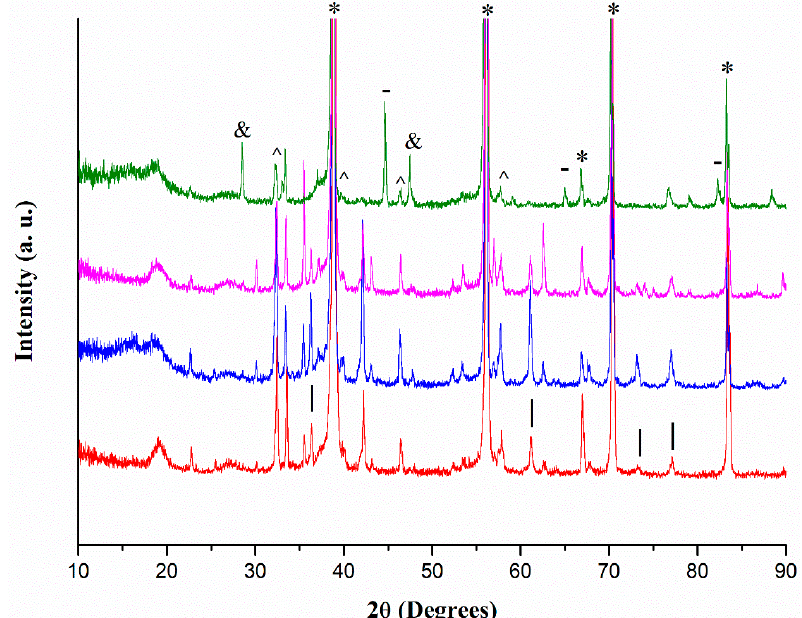
Figure 5. XRD patterns of samples calcined at 1000 ◦ C of: Fe 3 O 4 / 0.6CeO 2 (red line); F 3 O 4 :CITR / 0.6CeO 2 (blue line); Fe 3 O 4 :PVP / 0.6CeO 2 (magenta line); Fe 3 O 4 :OA / 0.6CeO 2 (green line). The marked peaks Figure 5: XRD patterns of samples calcined at 1000 °C of: Fe 3 O 4 /0.6CeO 2 (red line); F 3 O 4 :CITR/0.6CeO 2 belong to: * NaF (support); & ceria; ˆ cerium ferrite; - Fe; | (blue line); Fe 3 O 4 :PVP/0.6CeO 2 (magenta line); Fe 3 O 4 :OA/0.6CeO 2 (green line). The marked peaks belong to: * NaF (support); & ceria; ^ cerium ferrite; - Fe; | wüstite.